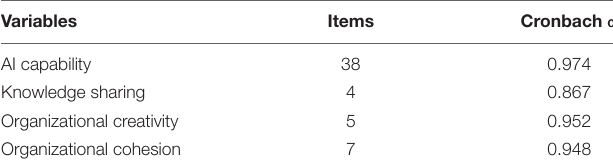
TABLE 3 | Reliability test